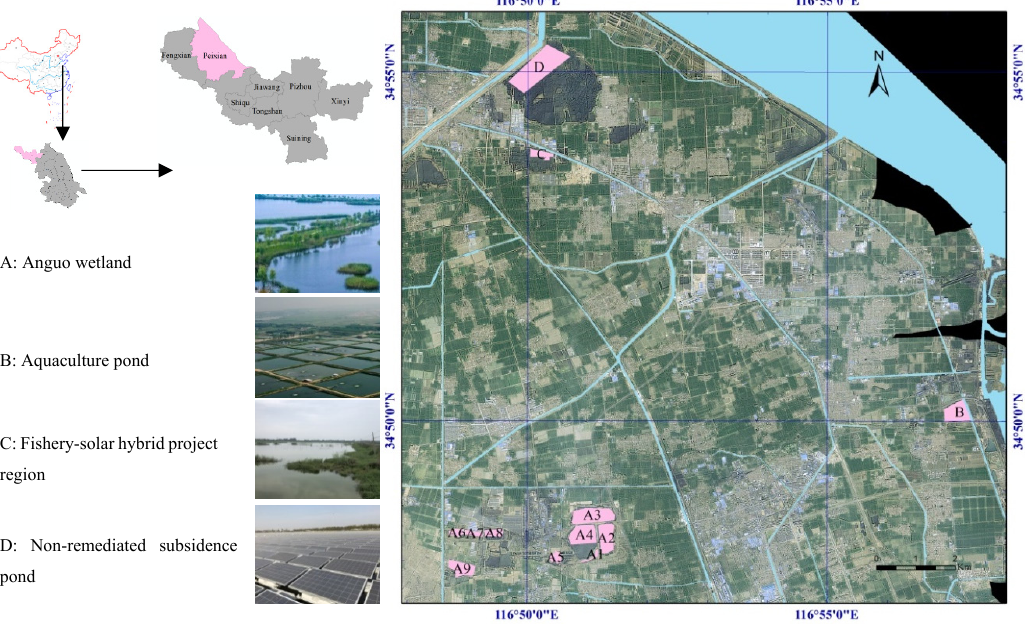
Figure 1. Sampling sites in Pei County, China.